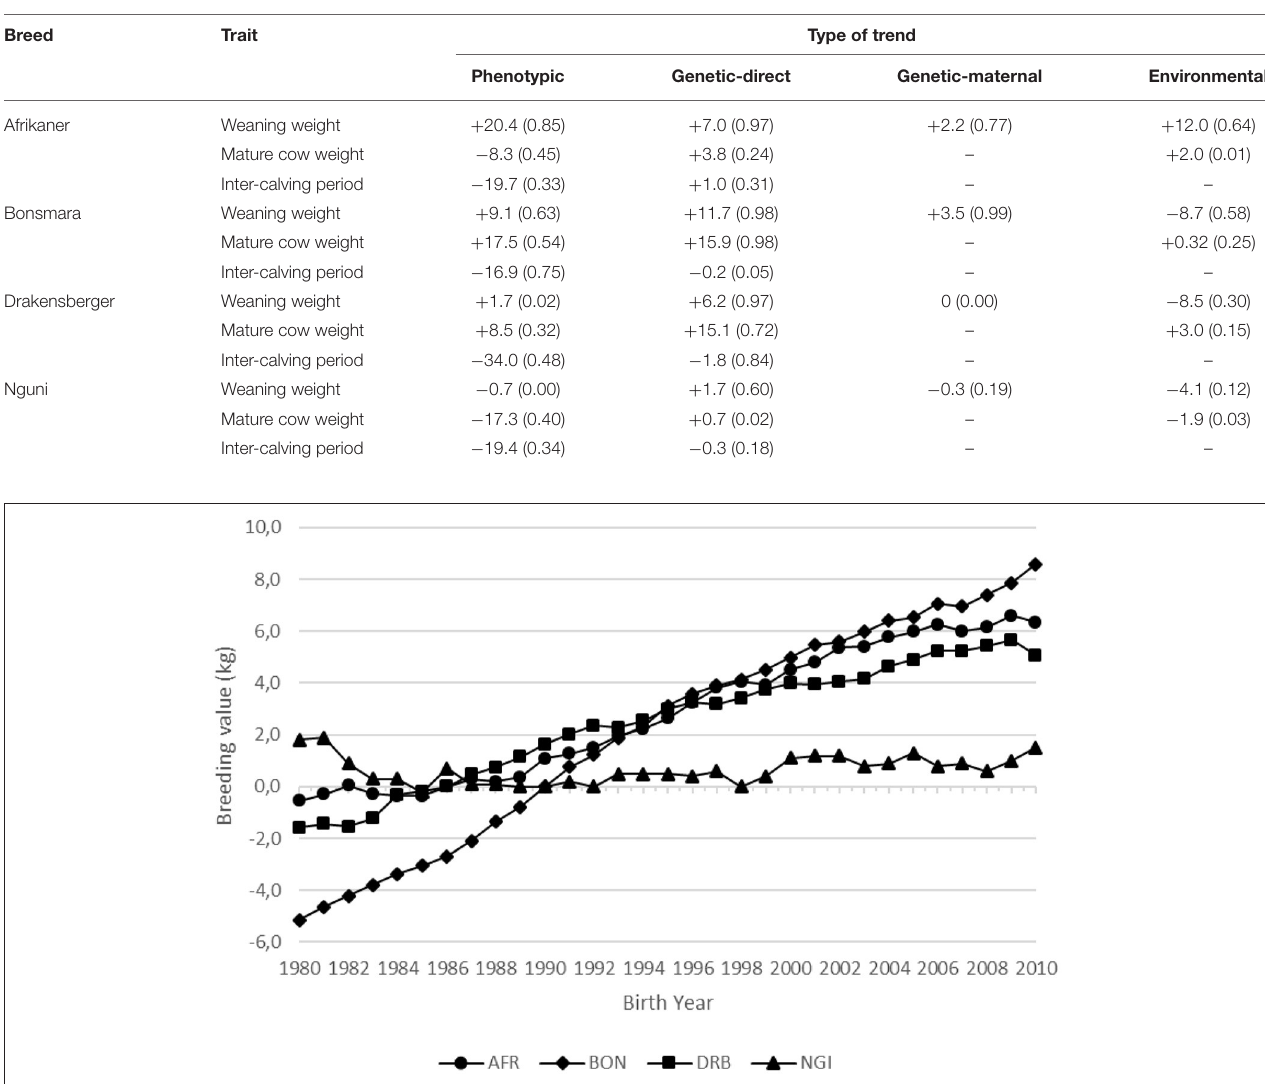
TABLE 2 | Summarized phenotypic, direct, and maternal genetic and environmental trends (change) for the two weight traits (in kg) and inter-calving period (in days) for the four landrace breeds ( R 2 in brackets). Breed Trait Type of trend Phenotypic Genetic-direct Genetic-maternal Environmental